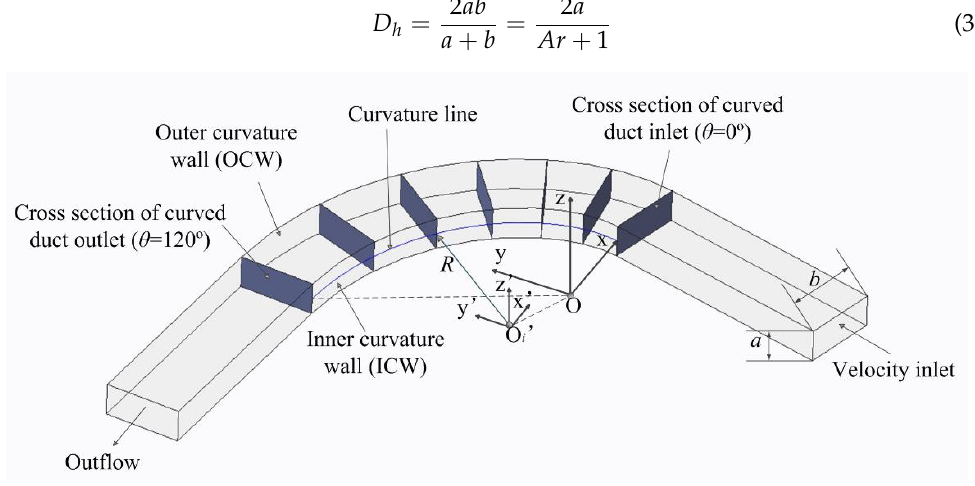
Figure 1. Computational geometry model [29].